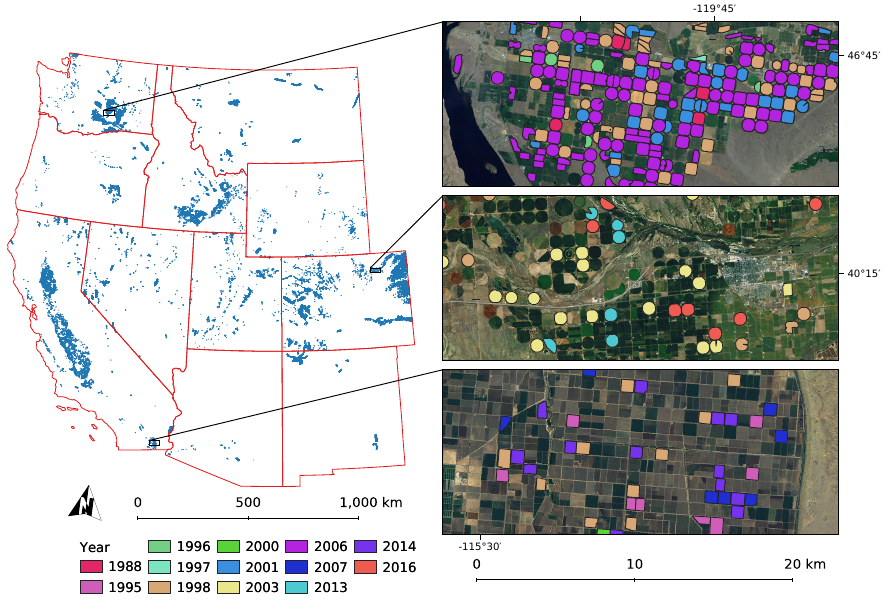
Figure 2. Training data from the irrigated class used to train IrrMapper. Table 1 shows the number of polygons and total irrigated training area from each class in each of the 11 Western States.